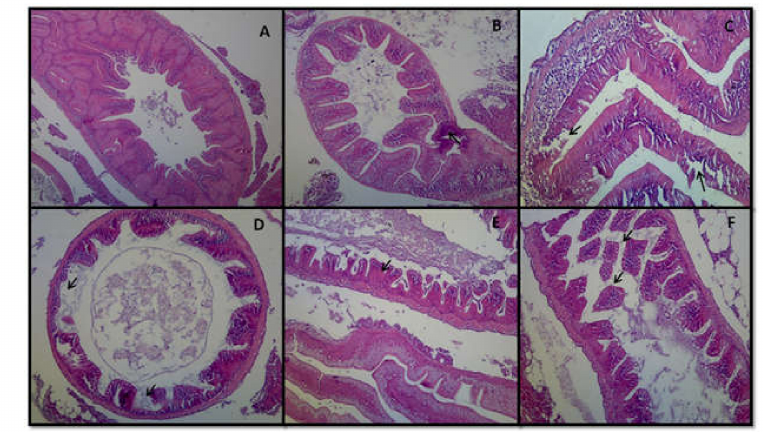
Figure 8. Representative hematoxylin and eosin stain histopathological image of intestine of rohu carp (400 × ) . ( A ): Normal intestine of control fish. ( B ): Hemorrhage in the mucosa and submucosal layer (T1). ( C ): Degeneration and damages of mucosal layer (T2). ( D ): Exhaustion of intestinal villi (T3). ( E ): Fusion of muscularis and submucosal layer (T3). ( F ): Necrosis and disintegration of intestinal villi (T3). Photos were taken using Nikon AF-S DX, Japan.